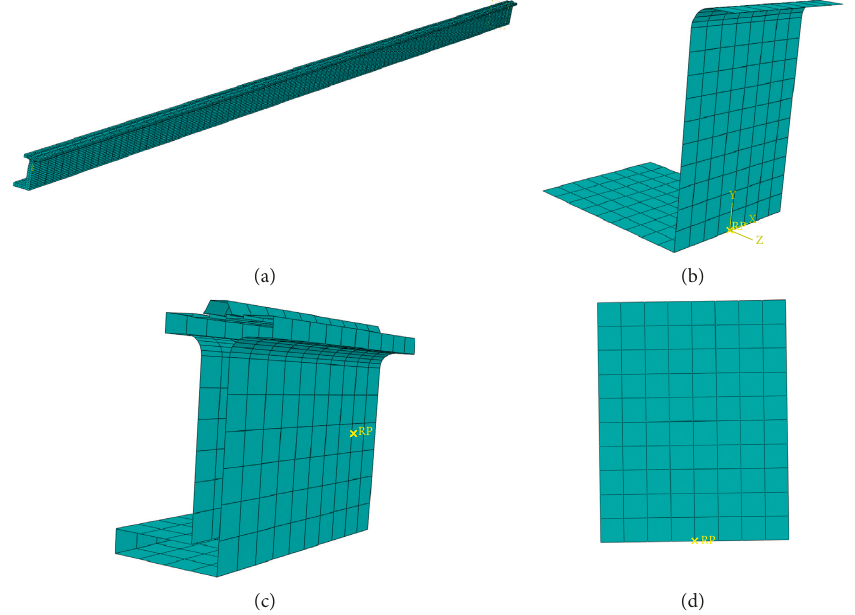
Figure 5: The parts diagram. (a) Aluminum profile. (b) Die units. (c) Clamp. (d) Limit screw.